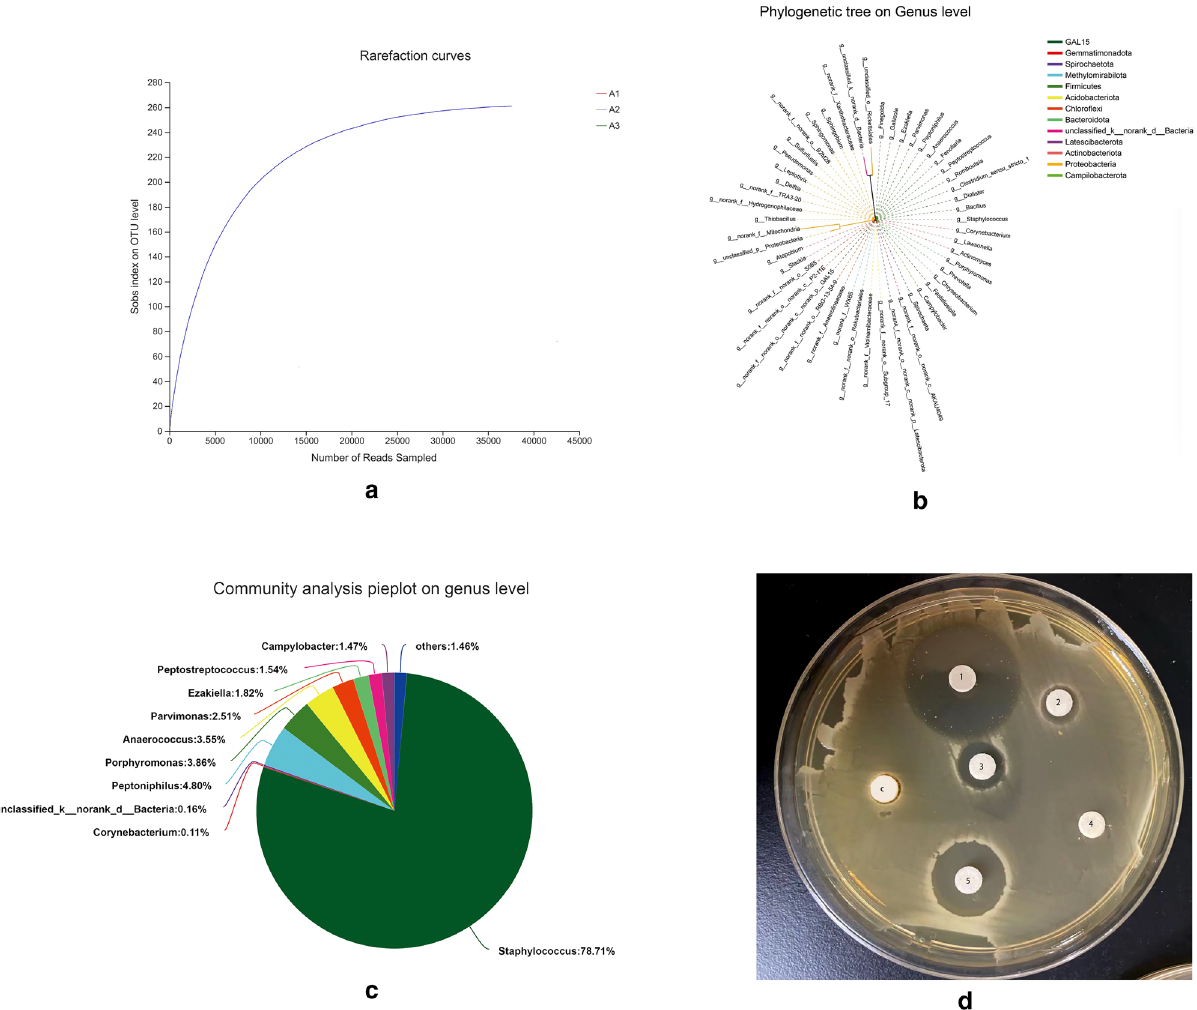
Figure 2. ( a ) The number of rarefaction curves in clinical isolates; ( b ) phylogenetic tree at the gene level; ( c ) the bacterial content in clinical isolates; ( d ) the KB paper method for common antibiotics sensitivity test. (1: vancomycin; 2: cefixime; 3: polymyxin; 4: tetracyclines; 5: OP-145; C: blank